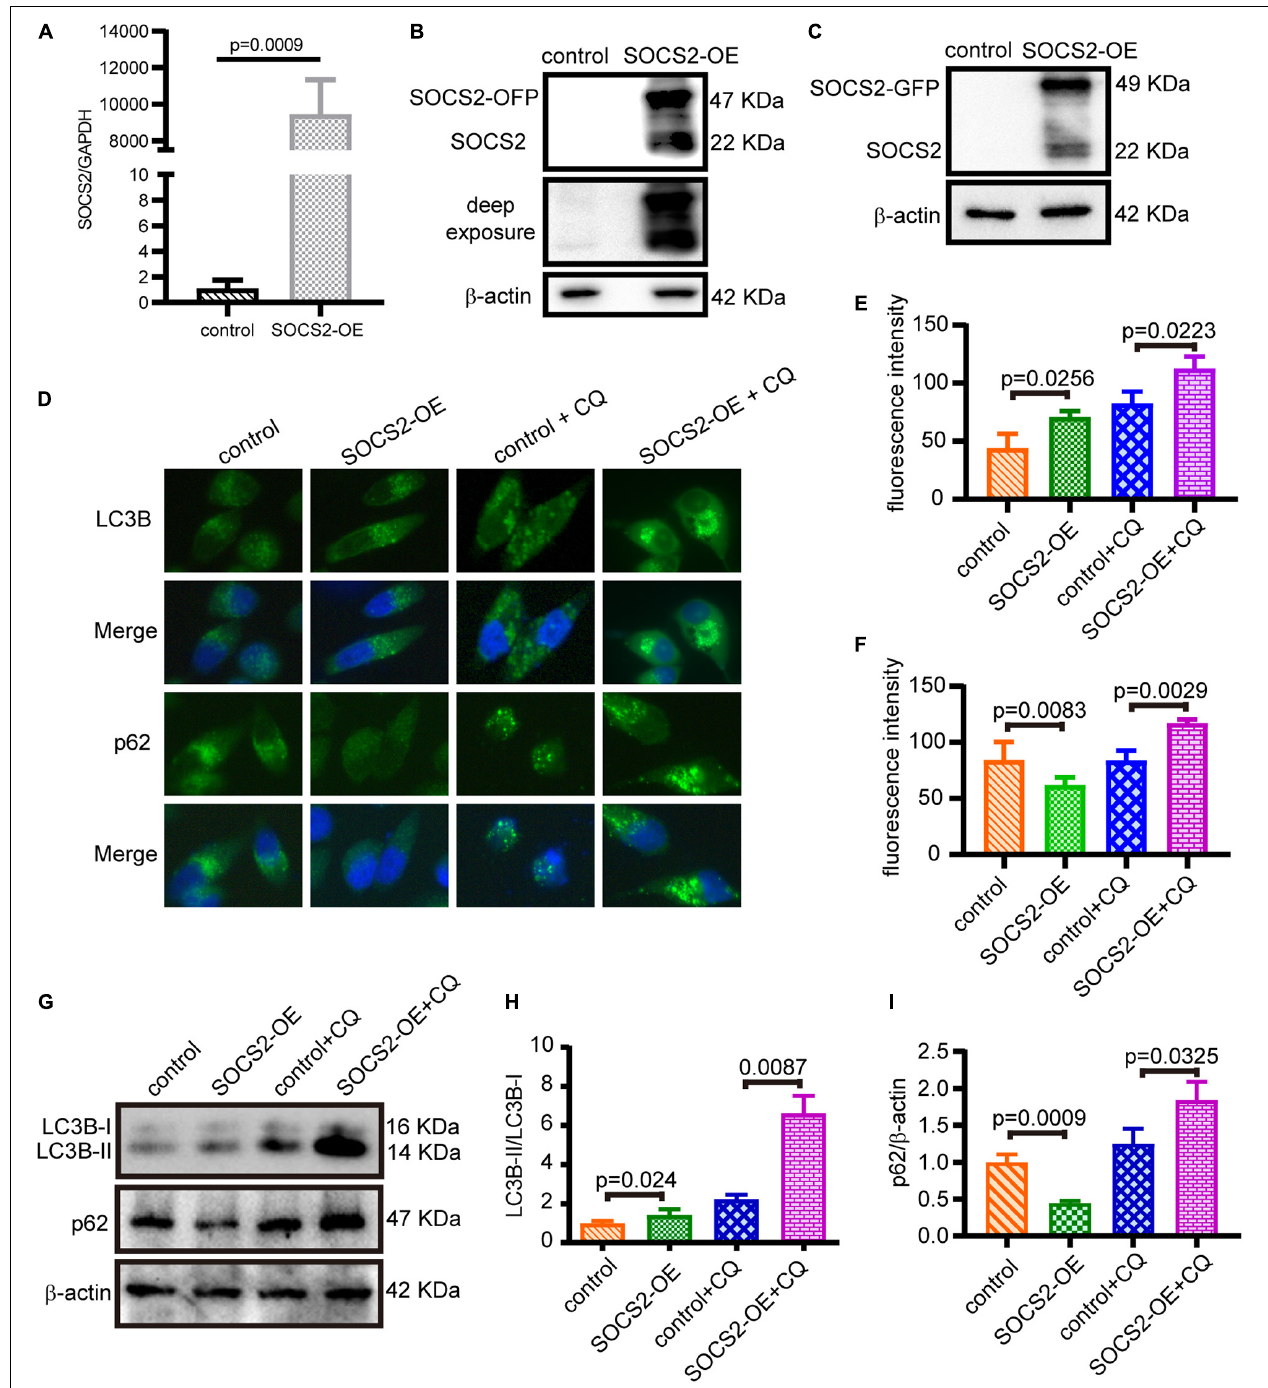
FIGURE 3 | SOCS2 promoted autophagy in ARPE-19 cells. (A) The mRNA expression of SOCS2 was detected by real-time quantitative PCR in ARPE-19 after transient transfection with pCMV3-Human-SOCS2-OFP expression plasmids or control vectors. The two-tailed unpaired t -test was used. (B,C) Western blot images of SOCS2-OFP and SOCS2-GFP were detected by the SOCS2 antibody to check the overexpression of SOCS2. (D) LC3B puncta dots (green) and p62 puncta dots (green) were stained by immunofluorescence in ARPE-19 cells transfected with pCMV3-Human-SOCS2-OFP expression plasmids or control vectors for 24 h, then cells were starved and treated with or without 30 µ M CQ for 24 h. (E,F) Fluorescence intensity of LC3B and p62 was quantified by ImageJ software. (G) Western blot detected the expression of LC3B and p62 in SOCS2 overexpressing ARPE-19 cells that were treated with or without 30 µ M CQ for 24 h. (H) The ratio of LC3B-II/LC3B-I was quantified by ImageJ software and normalized to β -actin. Values for the control were set to 1. (I) p62 was quantified by ImageJ software and normalized to β -actin. Values for the control were set to 1. Statistical significance was determined by using the two-tailed unpaired t -test.